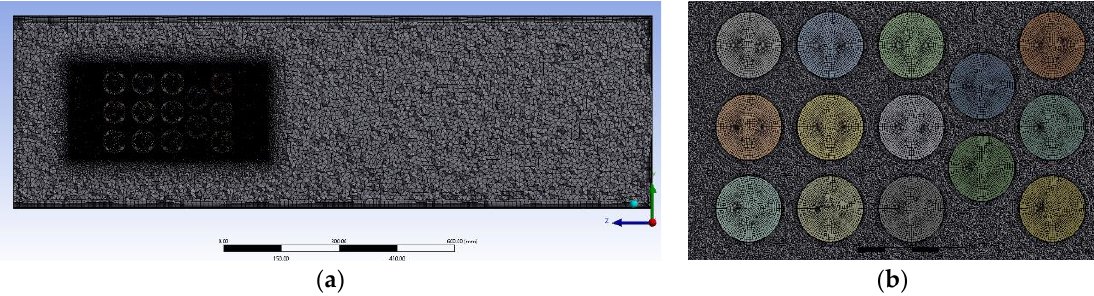
Figure 6. ( a ) Numerical grid in a longitudinal section across the computed domain, and ( b ) detail with the mesh in the SCs zone.